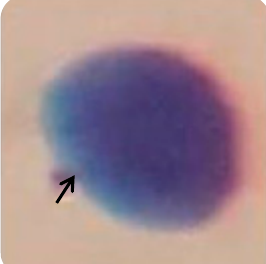
Figure 4. Illustration of the presence of an MN. Image obtained by optical microscopy at 100× showing the presence of an MN by the arrow.